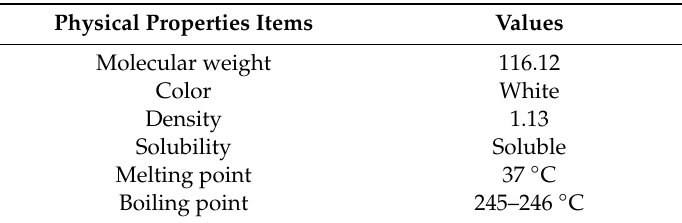
Table 1. The main physical properties of LA.